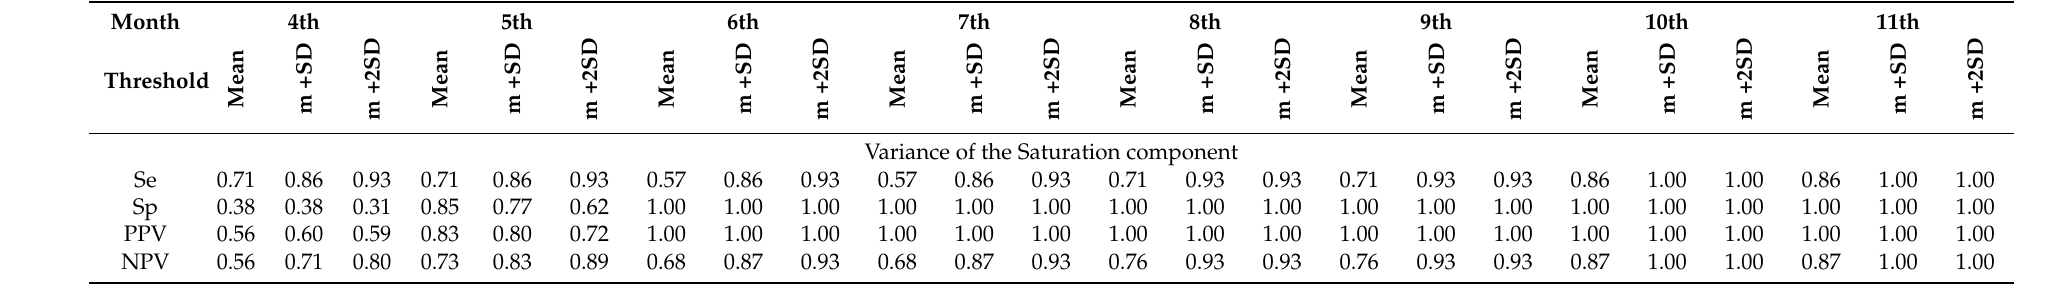
Table 3. Three thresholds (mean; mean ± SD (m ± SD); mean ± 2SD (m ± 2SD)) used to estimate the sensitivity (Se), specificity (Sp), positive predictive value (PPV), and negative predictive value (NPV) of advanced pregnancy detection using the selected features of Histogram Statistics and Gray Level Co-occurrence Matrix in the HSB color